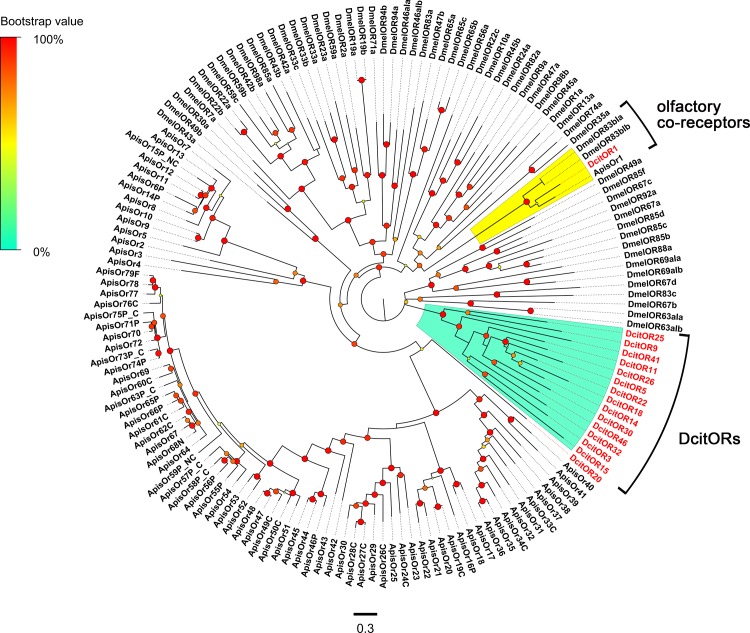
Phylogenetic relationship between DictORs.